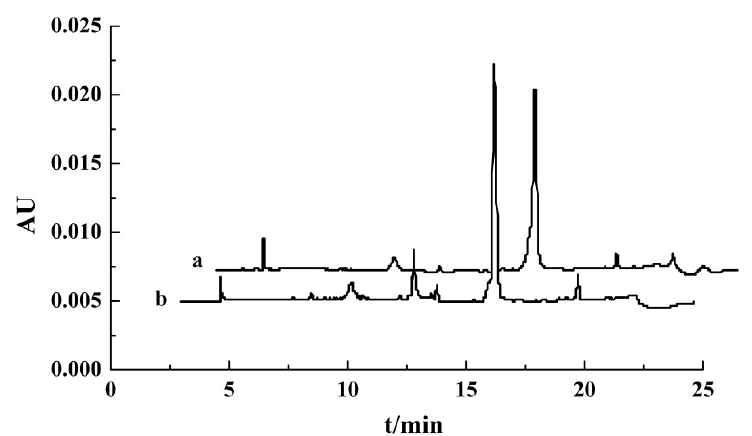
Figure 5. The RP-HPLC chromatograms of the OVA standard ( a ) and OVA purified from the top phase of the ATPF ( b ).